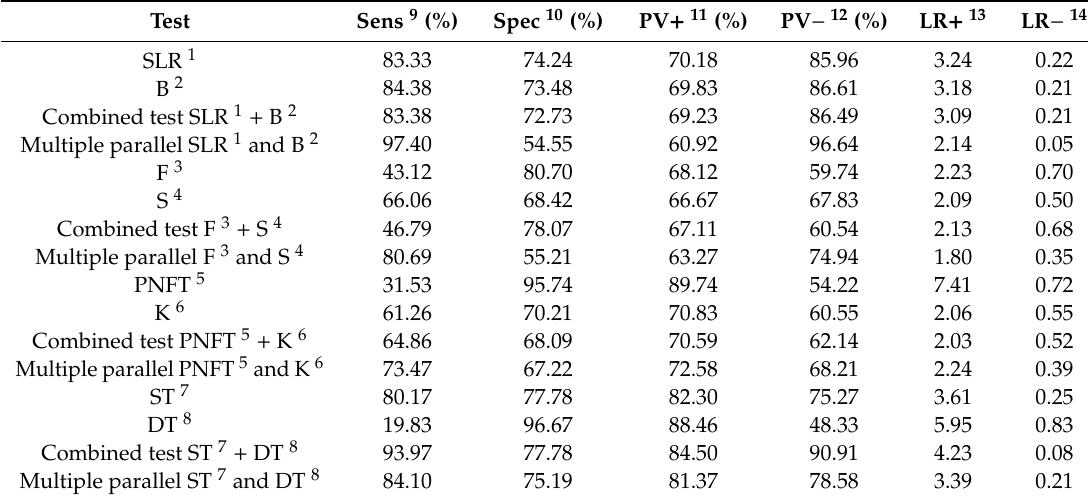
Table 3. Results of the validity